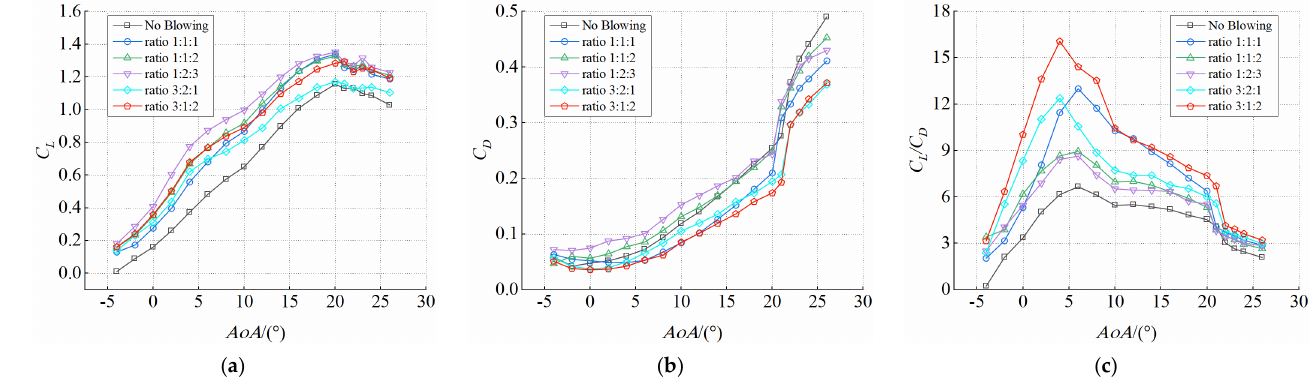
Figure 10. Wing aerodynamic characteristic curves at different blowing ratios ( U ∞ = 8 m/s, Q = 41.91 m 3 /h). ( a ) Lift coefficient. ( b ) Drag coefficient. ( c ) Lift-to-drag ratio.